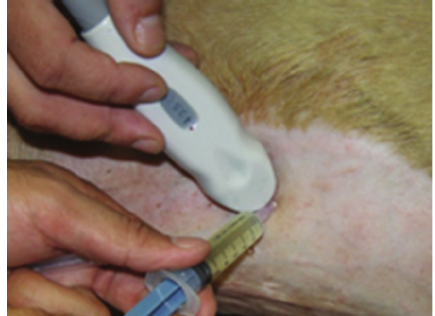
Figure 1: Six-year-old neutered male Labrador Retriever dog posi- tioned in left lateral recumbency for ultrasound-guided abdom- inocentesis. The needle is directed perpendicular to the abdominal wall, with care taken to avoid the spleen.